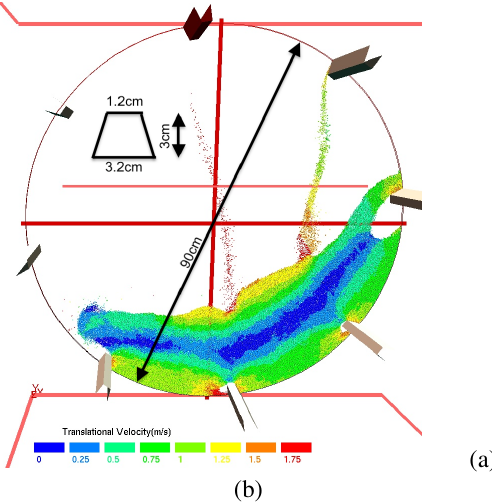
Figure 4: Ball mill modelled processes for this study with trans- lation speed (m / s) indicated in colour.